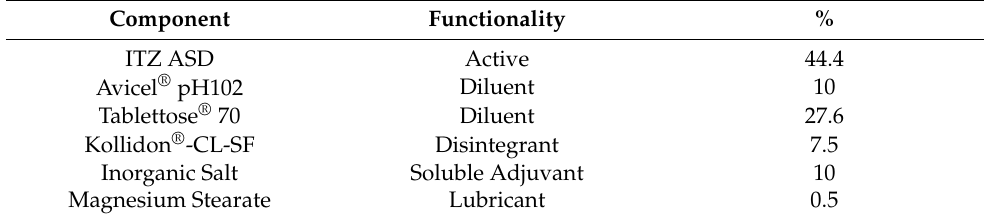
Table 3. ASD ITZ tablet formulations containing salts.